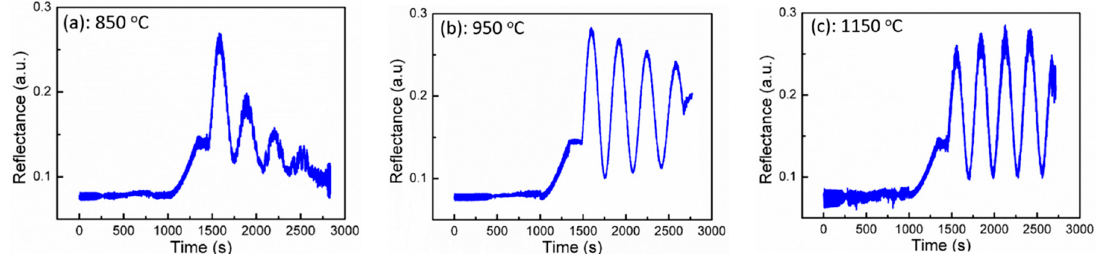
Figure 4. In-situ optical reflectance of N-polar GaN growth with an AlN buffer grown at temperatures of ( a ) 850 °C; ( b ) 950 °C; and ( c ) 1150 °C, respectively.